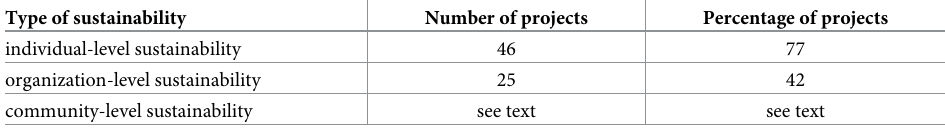
Table 6. Number and percentage of projects with individual-level sustainability or organizational-level sustain- ability at the time of this